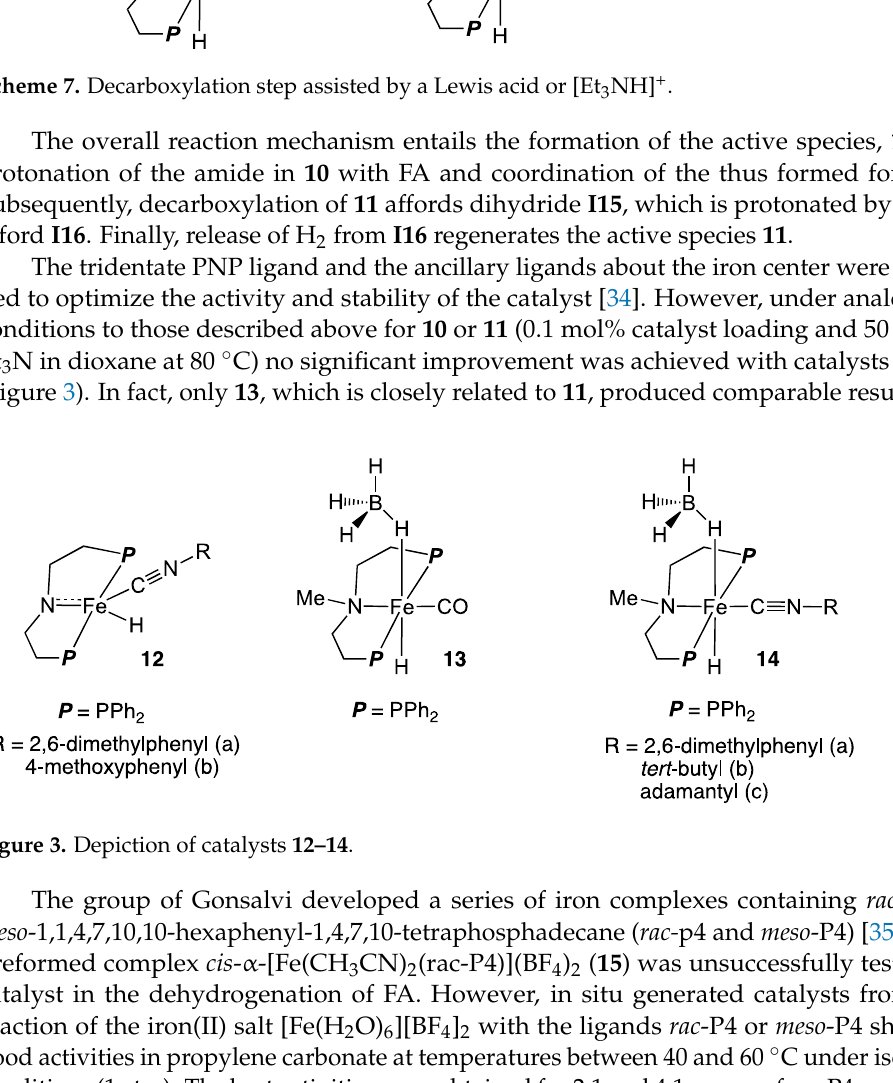
Scheme 7. Decarboxylation step assisted by a Lewis acid or [Et 3 NH] + .